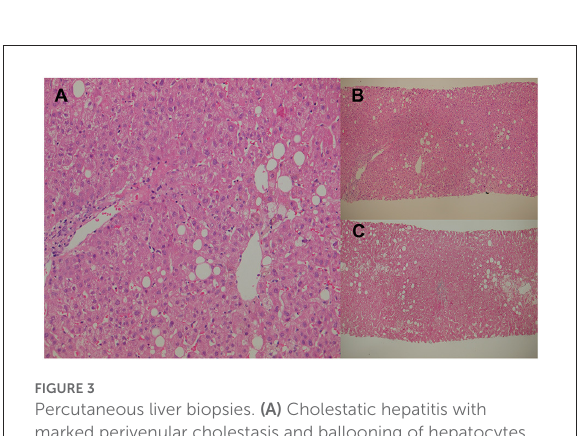
FIGURE3 Percutaneous liver biopsies. (A) Cholestatic hepatitis with marked perivenular cholestasis and ballooning of hepatocytes seen under high-power field hematoxylin and eosin (H&E) staining. (B) Initial liver biopsy showing 10 portal tracts, with only three surviving bile ducts that show degeneration under H&E staining. (C) Second liver biopsy showing an increase in the bile duct ratio under H&E